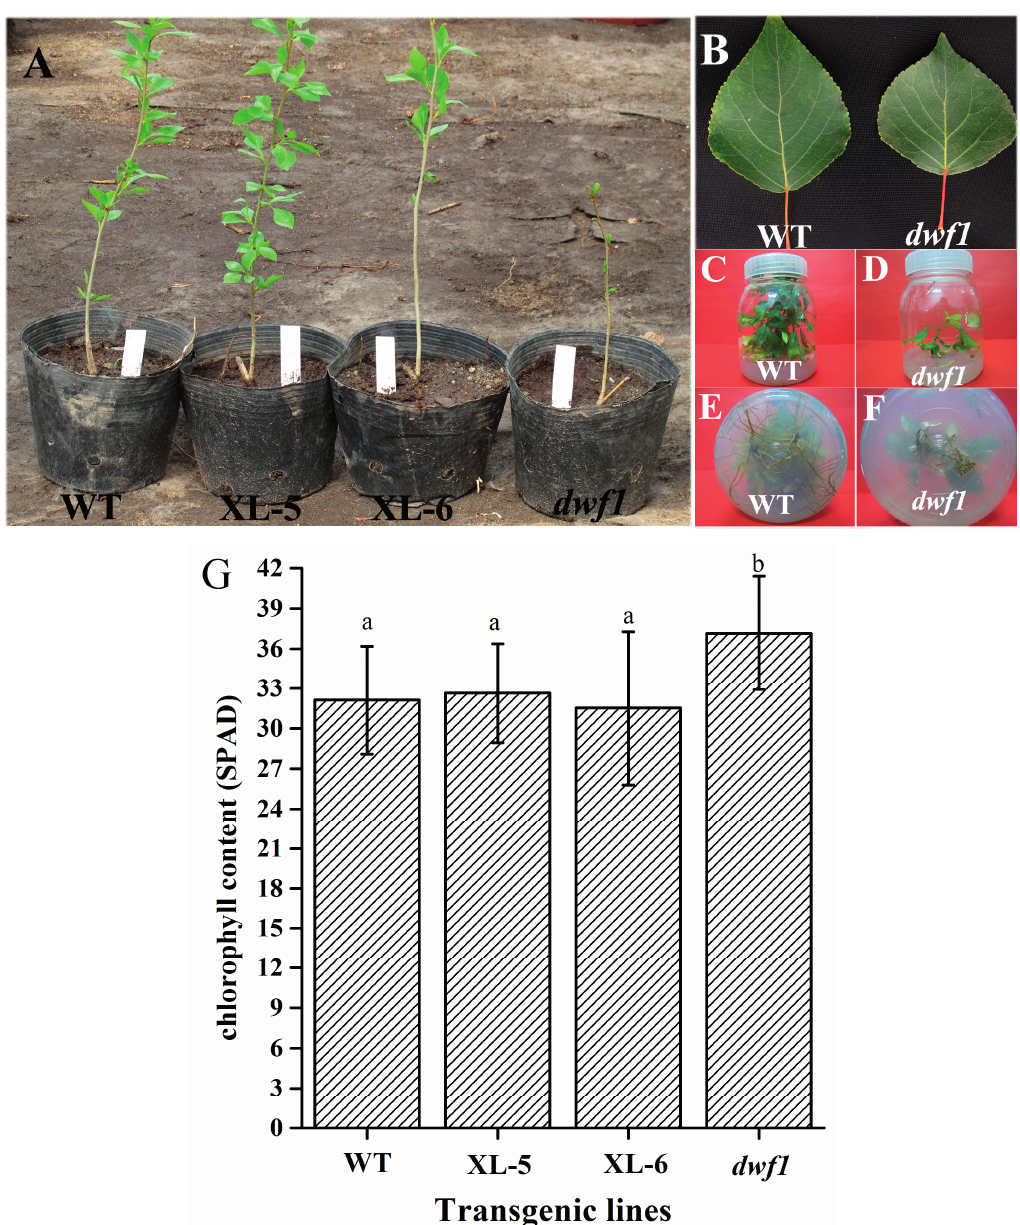
Figure 1. Phenotype of dwf1 . ( A ) Seedlings of XL-5, XL-6, dwf1 and wild-type. Under the same growth condition, dwf1 exhibited a dwarf phenotype compared with the XL-5, XL-6 and wild-type; ( B ) Leaves of dwf1 and wild-type. The leaf shape of dwf1 was slightly affected; ( C – F ) Seedlings of dwf1 and wild-type grown in vitro . ( F ) Dwf1 exhibited reduced root biomass and fewer lateral roots compared with ( E ) wild-type; and ( G ) Chlorophyll content of XL-5, XL-6, dwf1 and wild-type. Error bar indicates standard error (SD). Single factor ANOVA, followed by Tukey Kramer post-hoc test was employed in this study. Sixty leaves from six individuals of each transgenic line and wild-type were measured. Letters (a and b) on the graph denote significant differences ( p <